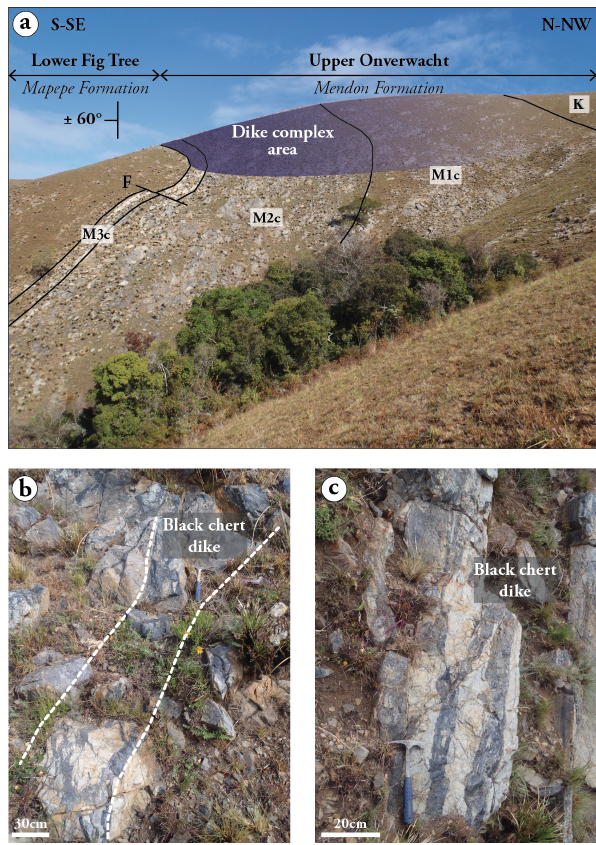
Figure 3. (a) Photo of the Barite Valley area (NE side of the hill) showing the main limits of the Mendon Formation and Mapepe For- mation. The series gets younger to the S-SE and dips steeply at ± 60 ◦ in the same direction. The main dike complex area begins in the sedimentary units M3c and extends down to the silicified ko- matiitic flows (K). Stratigraphy is detailed in Fig. 1b. Photos (b) and (c) are examples of black chert dikes cross-cutting the silicified rocks of the upper Mendon